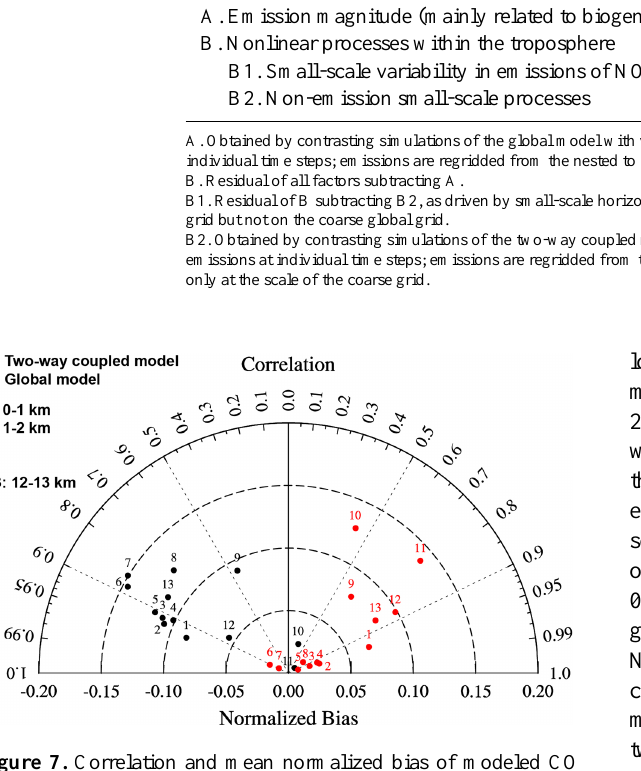
of differences in emission magnitude between the two-way coupled model and the global model. The residual difference of 6.1 % (i.e., 9.6 % minus 3.5 %) represents the combined effect of all factors other than emission